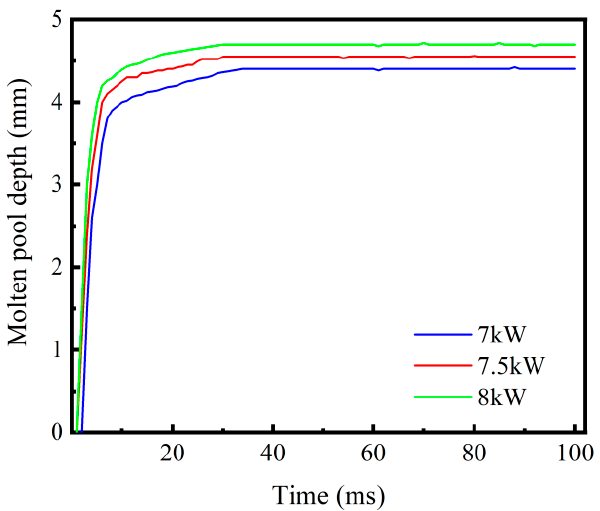
Figure 14. Depth of the melt pool below the keyhole at different laser powers.